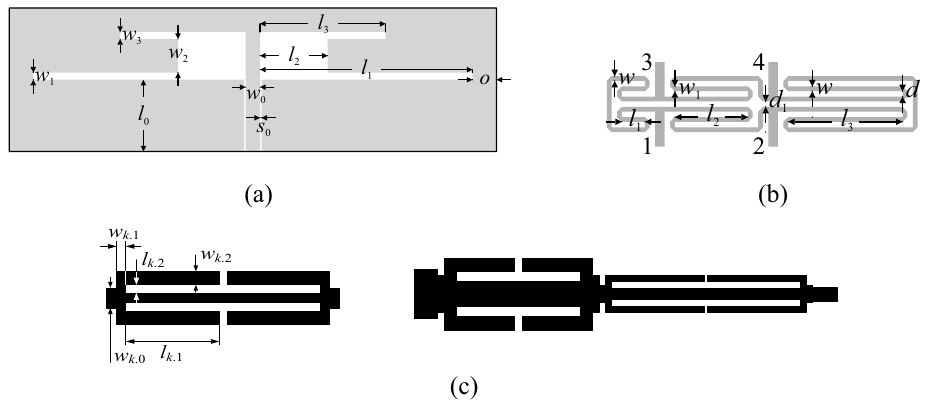
Figure 6. Verification structures: ( a ) uniplanar dual-band dipole antenna 63 , ( b ) miniaturized rat-race coupler (RRC) 64 , ( c ) compact two-section impedance matching transformer: CMRC cell (left) and complete transformer structure (right) 65 ; k refers to a section